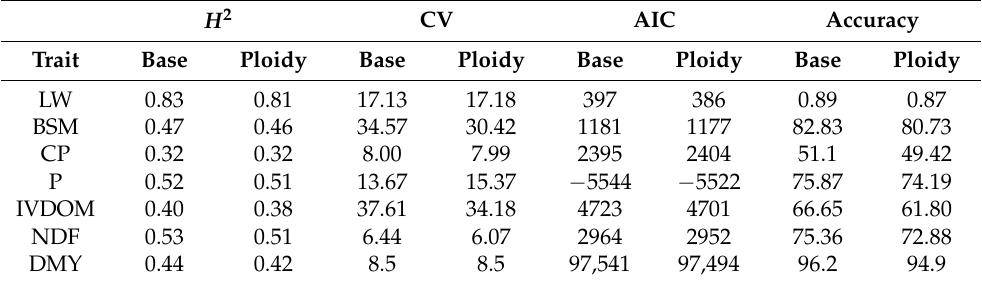
Table 3. Comparison of models excluding (Base) and including ploidy as a fixed effect for the estimation of broad-sense heritability ( H 2 ), Coefficient of Variation (CV), Akaike Information Criteria (AIC), and accuracy for the USDA forage bermudagrass germplasm for the following traits: leaf width (cm) (LW), Bermudagrass Stem Maggot (BSM) tolerance (1 = 10 percent or less damage, 9 = 90 percent or more damage), dry matter yield (g kg − 1 ) (DMY), and the following nutritive value traits expressed in g kg − 1 : crude protein (CP), phosphorus (P), in vitro digestible organic matter (IVDOM), neutral detergent fiber